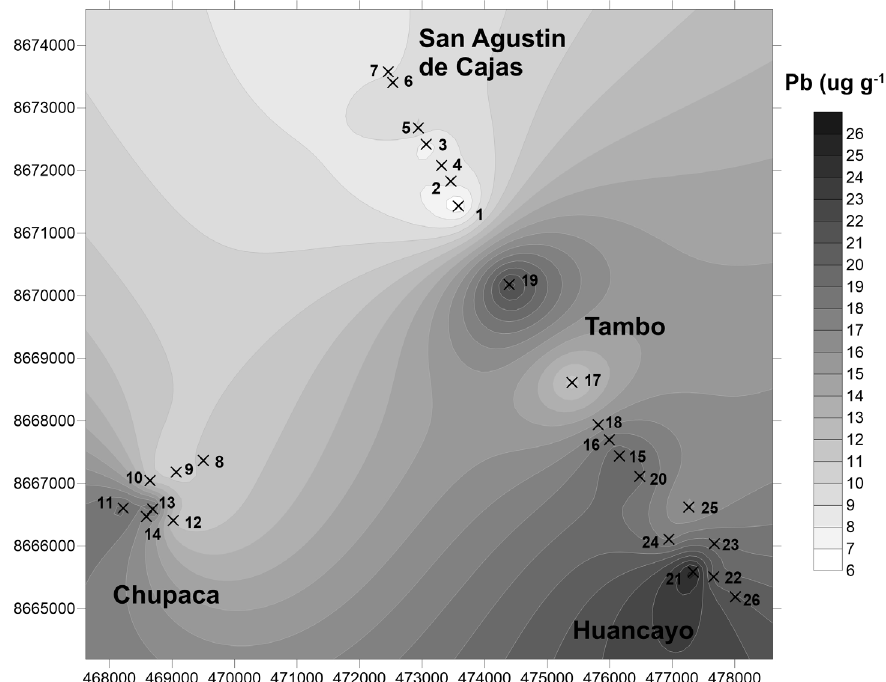
Figure 5. Distribution map of Pb concentrations.